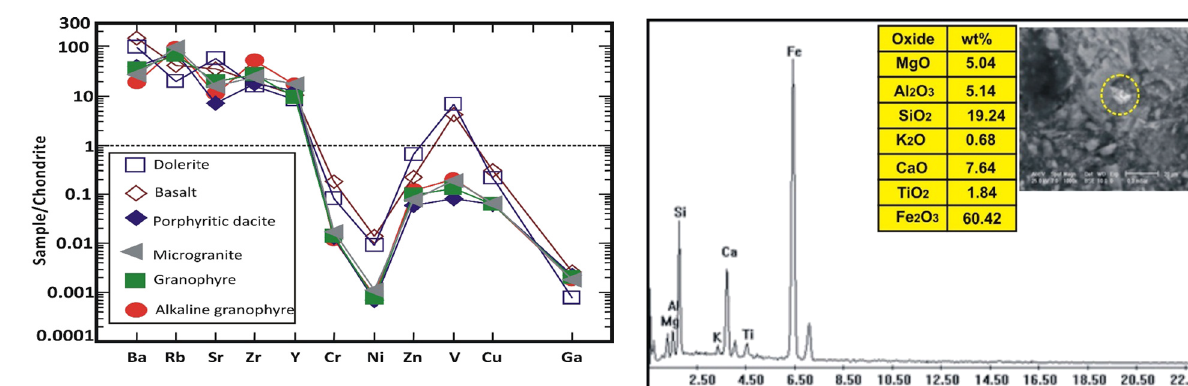
Figure 10: Distribution pattern of trace elements of di ff erent dikes normalized to average chondrite ( Wood et al. [ 29 ])